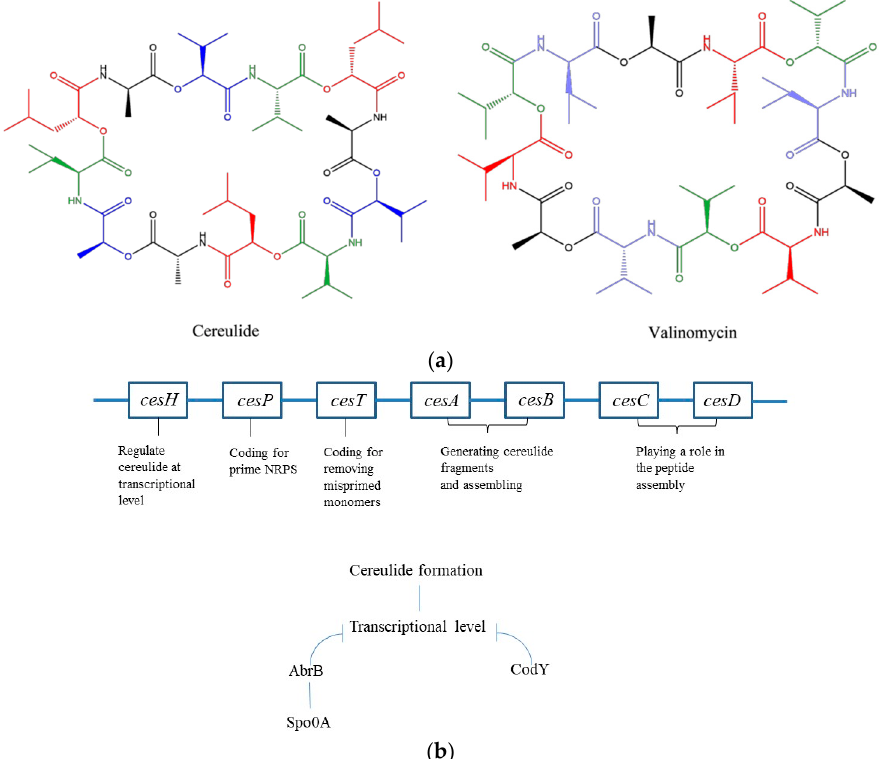
Figure 1. ( a ) Structures of cereulide and valinomycin. For cereulide, the red, black, blue and green fragments represent D-Oxy-Leu, D-Ala, L-Oxy-Val and L-val, respectively. For valinomycin, the red, green, blue and black fragments represent L-val, D-O-Hyi, D-val and L-Oxy-Lac, respectively. ( b ) ces genes involved in cereulide formation and regulators at the transcriptional level.